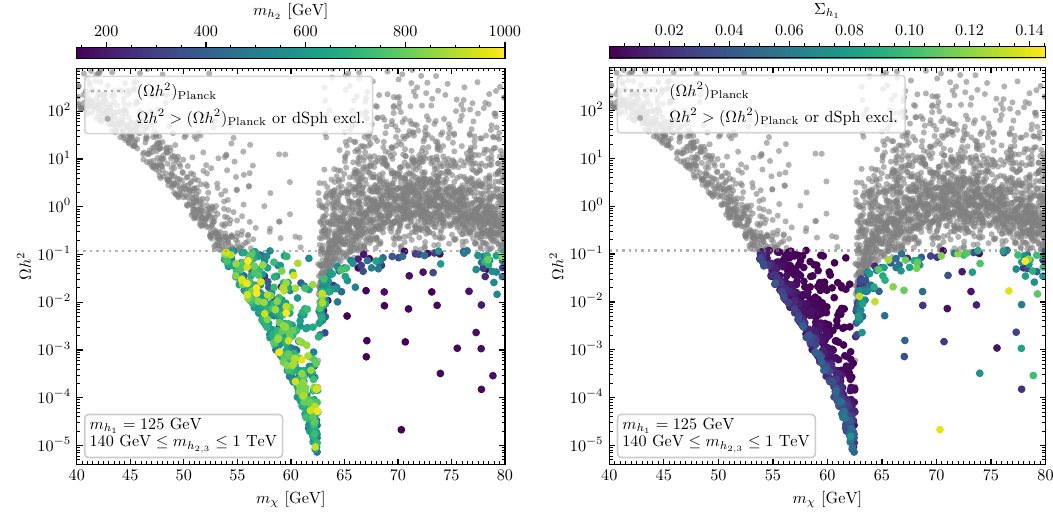
Figure 4 . Relic abundance Ω h 2 as predicted by thermal freeze-out in dependence of m χ . The colour coding indicates the values of m h (left) and the values of Σ h (right). Grey points are excluded by 2 2 Ω h 2 > (Ω h 2 ) Planck or Fermi dSph